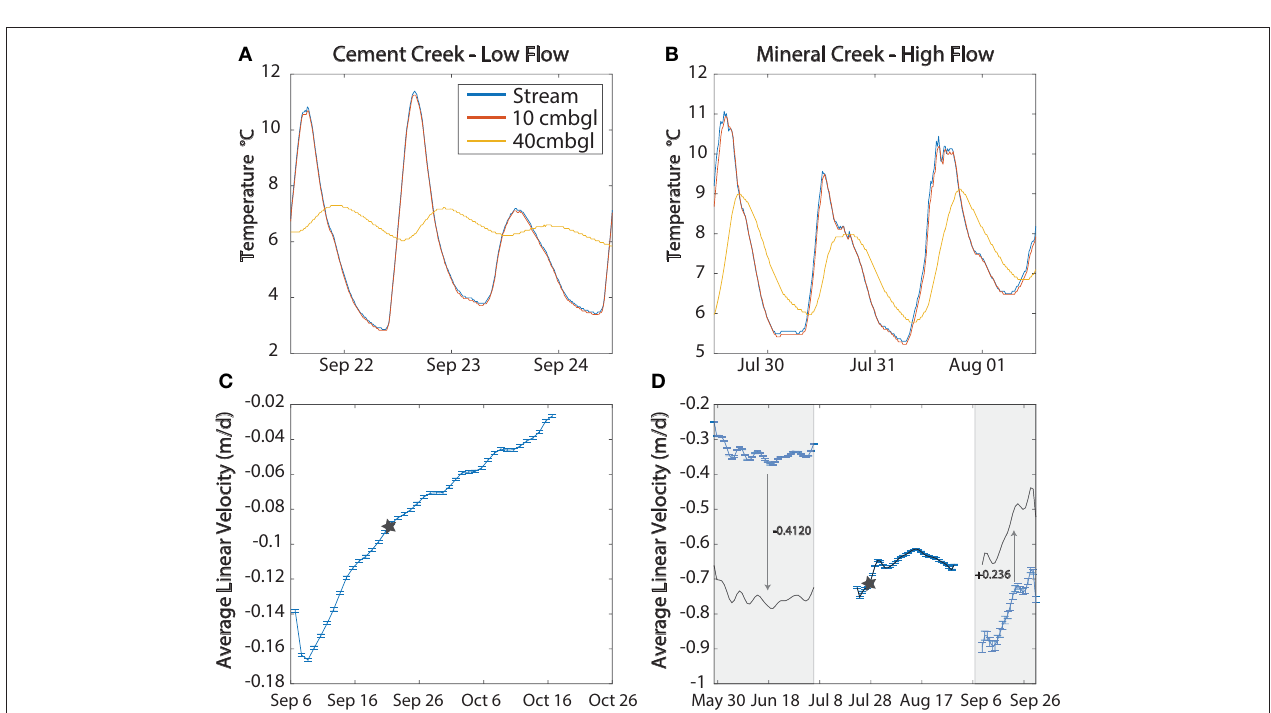
FIGURE 3 | Temperature time-series data for (A) Cement Creek–Prospect Gulch during the low-flow tracer test and (B) Mineral Creek–Chattanooga Fen during the high-flow tracer test, as well as average linear velocity estimates based on amplitude ratios ( V Ar ) (Hatch et al., 2006) for (C) Cement Creek and (D) Mineral Creek in 2019. Data are not presented for the high-flow tracer test in Cement Creek due to temperature sensor damage and loss of data. The black stars indicate the average linear velocity at the approximate time of the tracer tests. Note that the thermal sensors were removed from Mineral Creek on September 26, before the tracer test was completed on September 28. The blue dashed lines represent uncertainty in the average linear velocity estimates. Negative velocities indicate water fluxes from the stream into the subsurface (e.g., losing stream conditions). The gray-shaded areas in (D) indicate high uncertainty velocity estimates given that the estimates were calculated only from stream temperature and 10 cmbgl temperature sensors due to damage of the 40 cmbgl temperature sensor. Values on plot (D) represent the offset used to correct the Mineral Creek average linear velocity estimates in the shaded regions to the estimates made for the July–August data. We subtracted 0.412 m/day from all velocity estimates measured from May 30 to July 7 and added 0.236 m/day to all estimates made in September, assuming that the measurements made during these time periods were offset from the low uncertainty velocity estimates measured from July 8 through